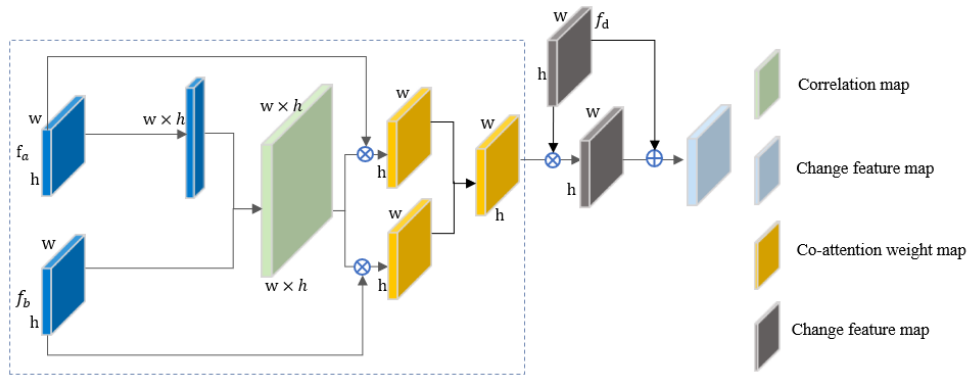
Figure 4. Overview of changed feature map produced by co-attention module.